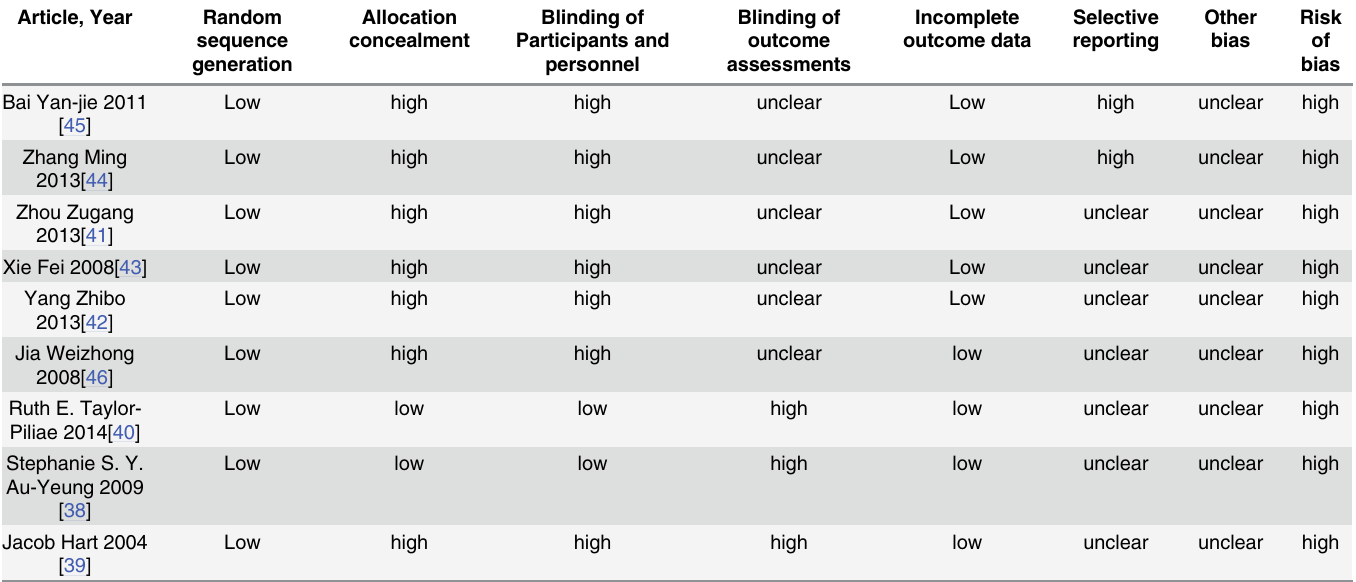
Table 2. The risk of bias about included